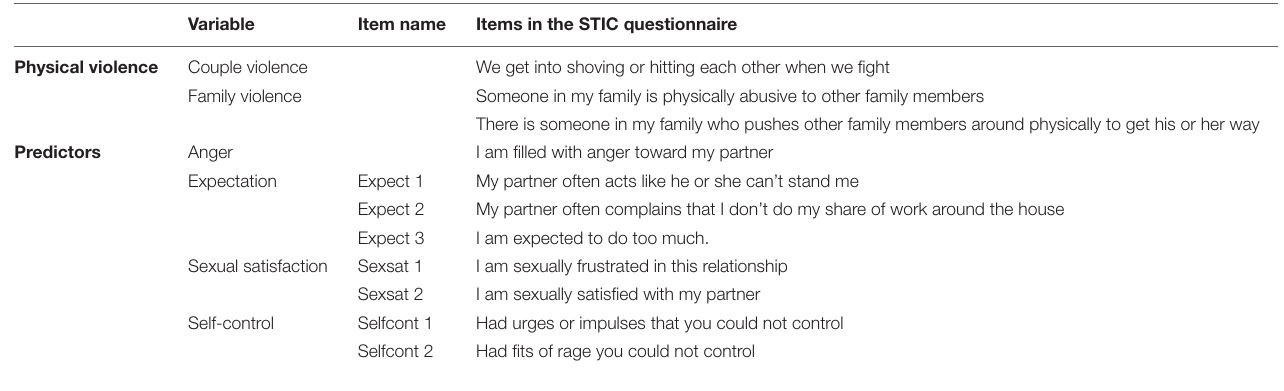
TABLE 1 | List of items used to model physical violence.